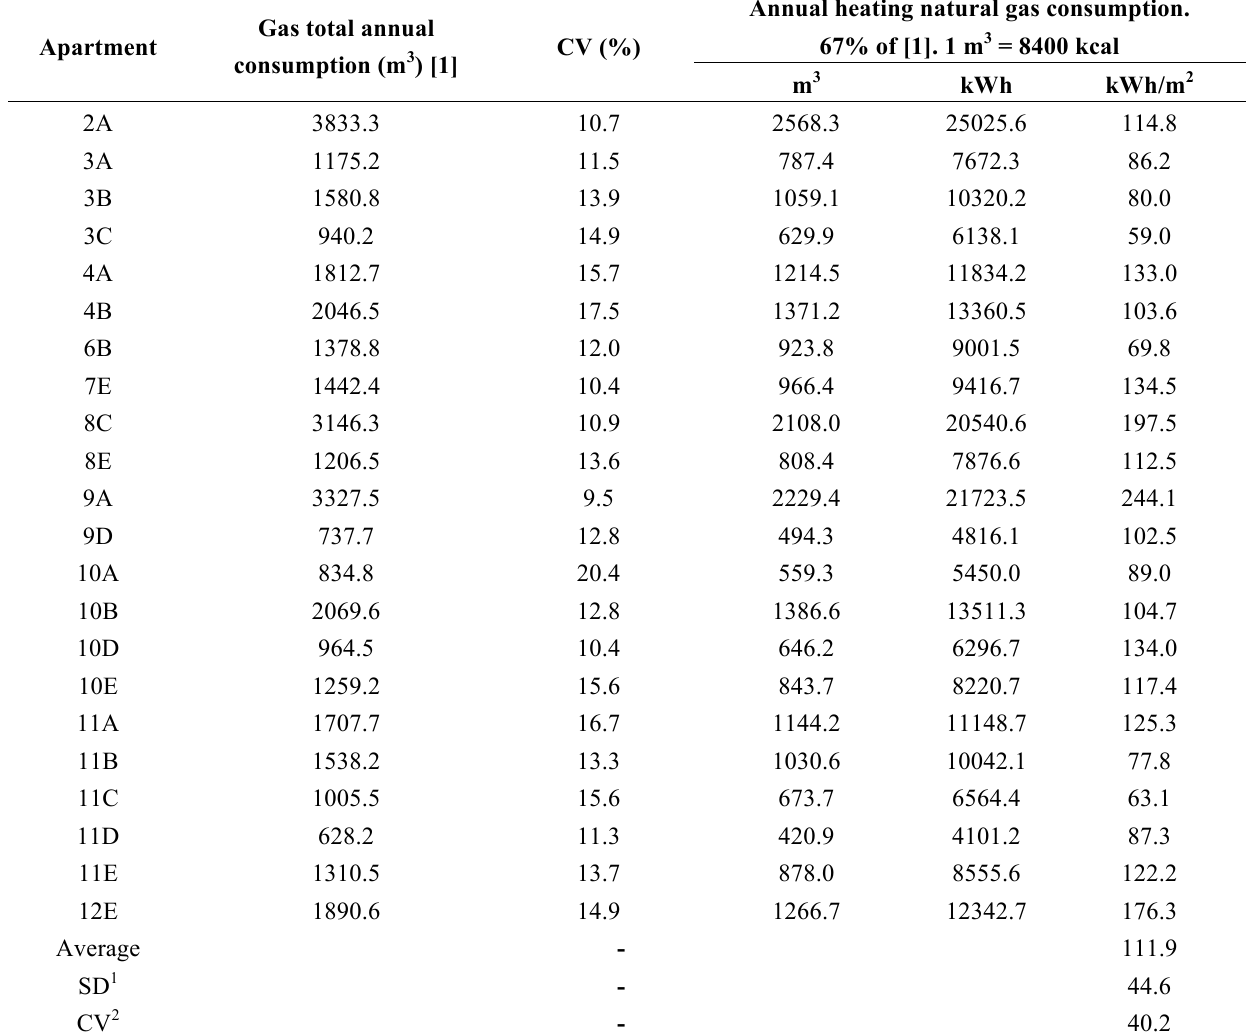
Table 3. Average and variability of historical annual natural gas consumption and heating energy consumption estimated according to the percentage defined by the fluid distribution company (period: